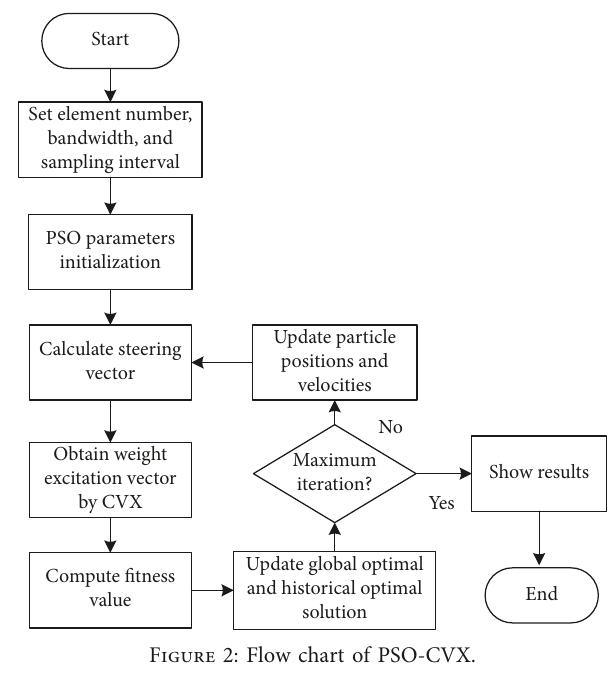
Figure 2: Flow chart of